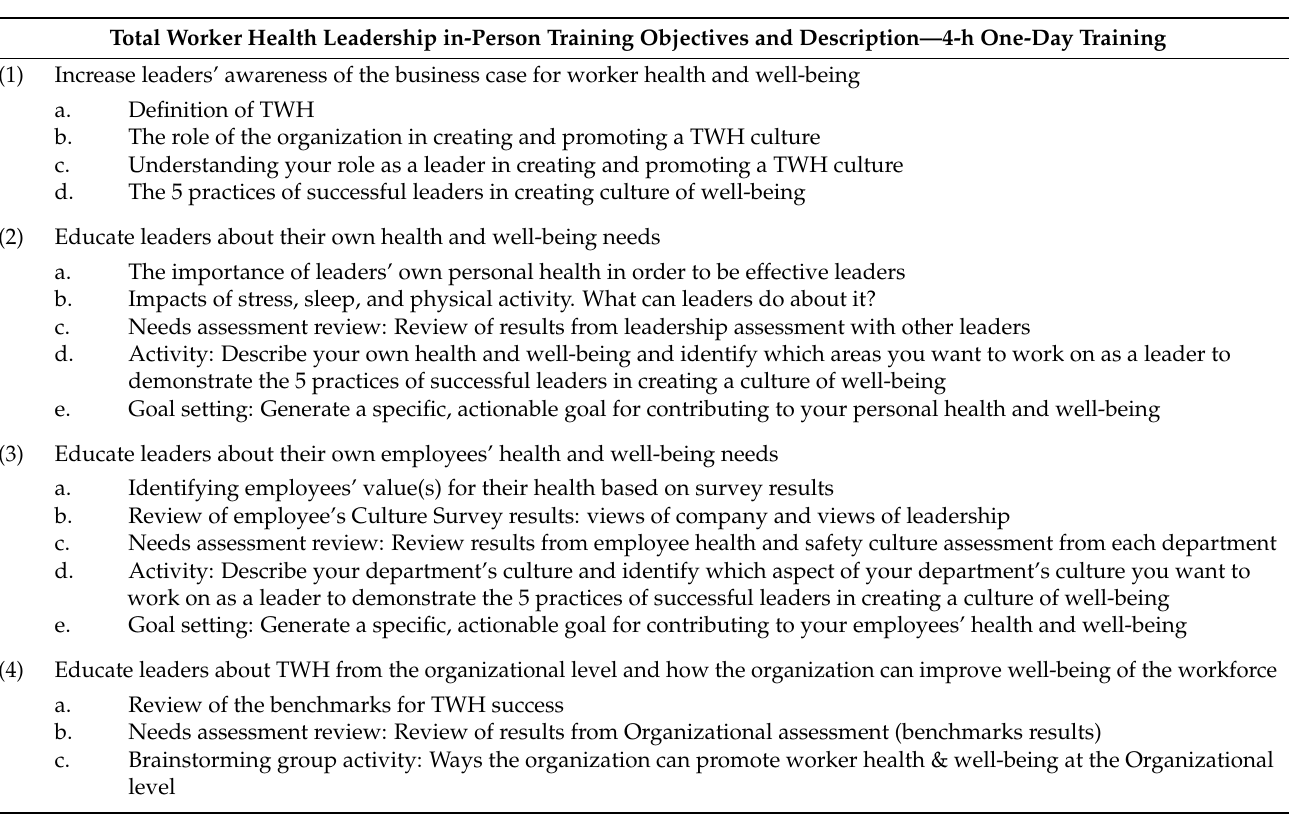
Table 2. International Total Worker Health Training objectives and